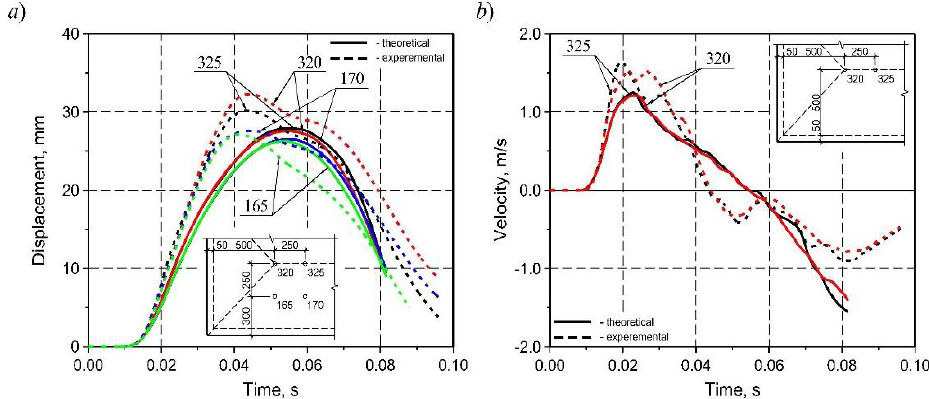
Fig. 5. Comparison of theoretical and experimental displacements ( а ) and velocities ( b ) of reinforced concrete slabs on yielding supports with hardening.